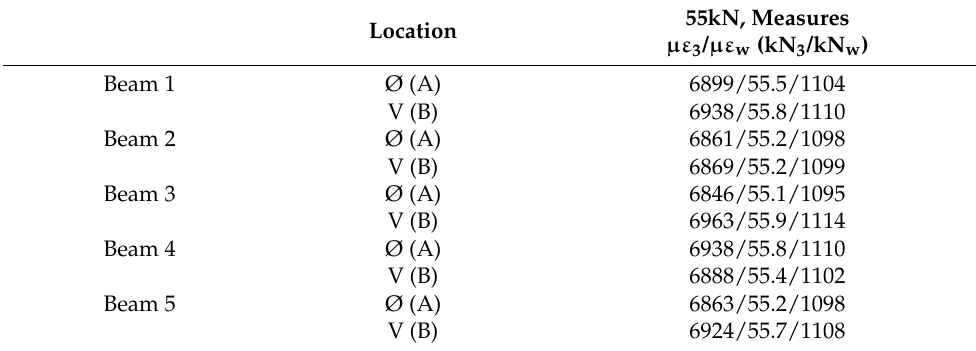
Table 6. Final pre-stressing magnitudes just before adhesive